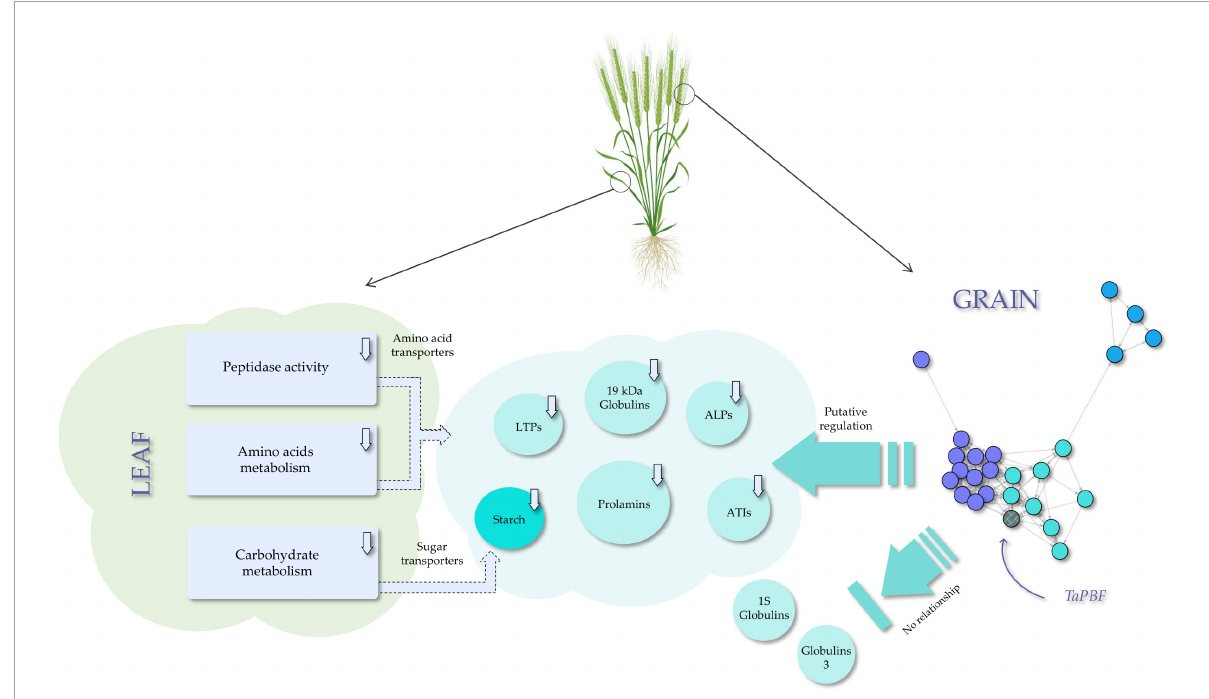
FIGURE9 Model of the transcription factors (TFs) network role in the regulation of the seed storage proteins (SSPs) and starch synthesis, and the effect on the grain-leaf communication-related processes in a RNAi line with gliadins